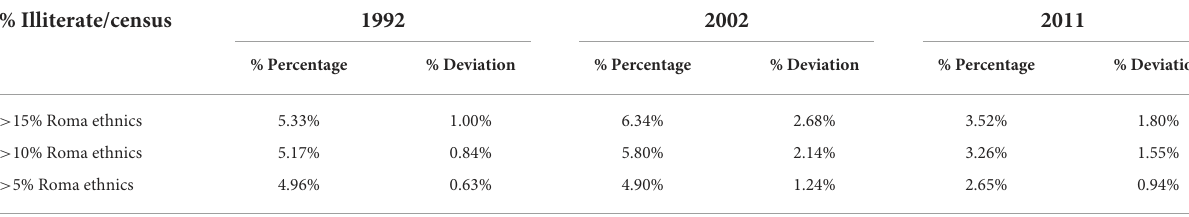
TABLE 3 Distribution of illiterate percentages and deviations in communes within 5– > 15% Roma ethnics.